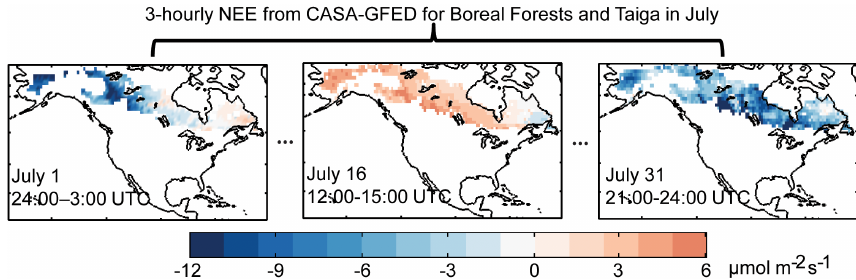
Figure 2. Illustration of the 1 ◦ × 1 ◦ and 3-hourly spatiotemporal variability of NEE simulated by CASA-GFED for Boreal Forests and Taiga in July. A vector including these 1 ◦ × 1 ◦ and 3-hourly fluxes corresponds to one ancillary variable (i.e., one column) in X .